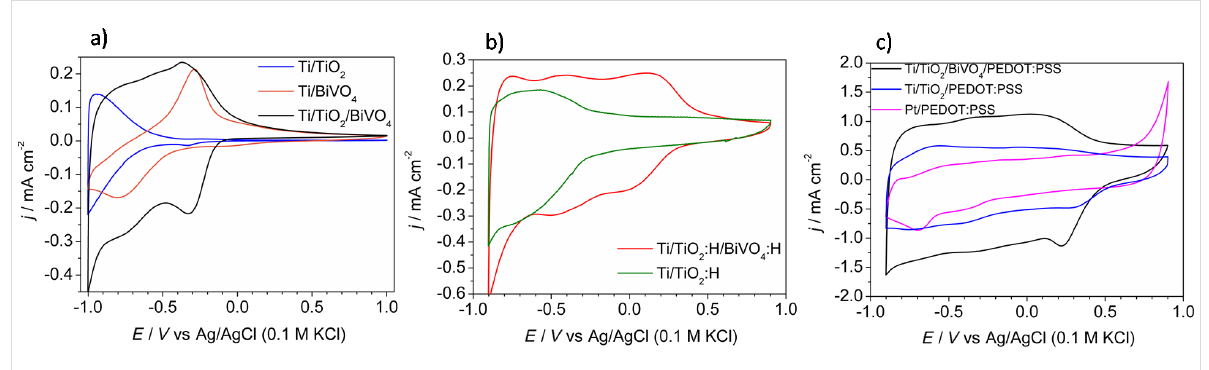
Figure 4: The cyclic voltammetry curves recorded in aqueous 0.5 M K 2 SO 4 with scan rate 100 mV·s − 1 of: a) Ti/TiO 2 , Ti/BiVO 4 , and Ti/TiO 2 /BiVO 4 , b) Ti/TiO 2 :H, Ti/TiO 2 :H/BiVO 4 :H, and c) Ti/TiO 2 /BiVO 4 /PEDOT:PSS, Ti/TiO 2 /PEDOT:PSS, and